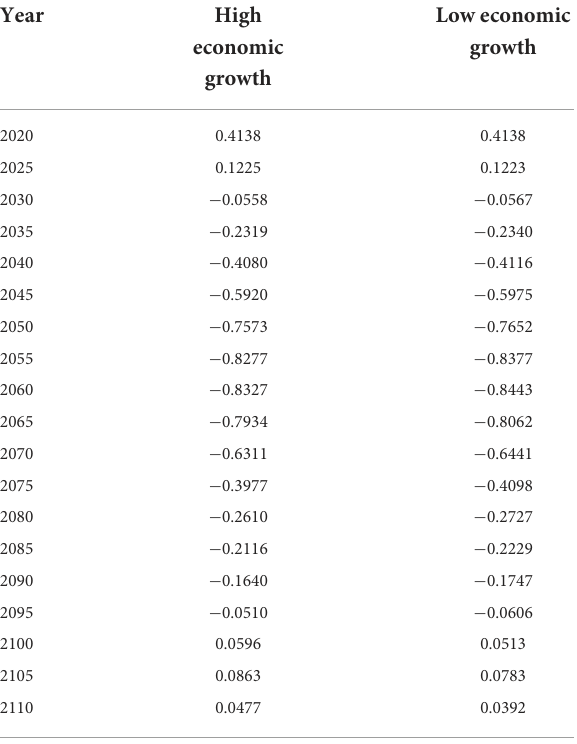
TABLE 4 Percentage of the accumulated amount of LTCI funds in GDP under the combination of income distribution scenario C and total fertility rate 1.8 scenario